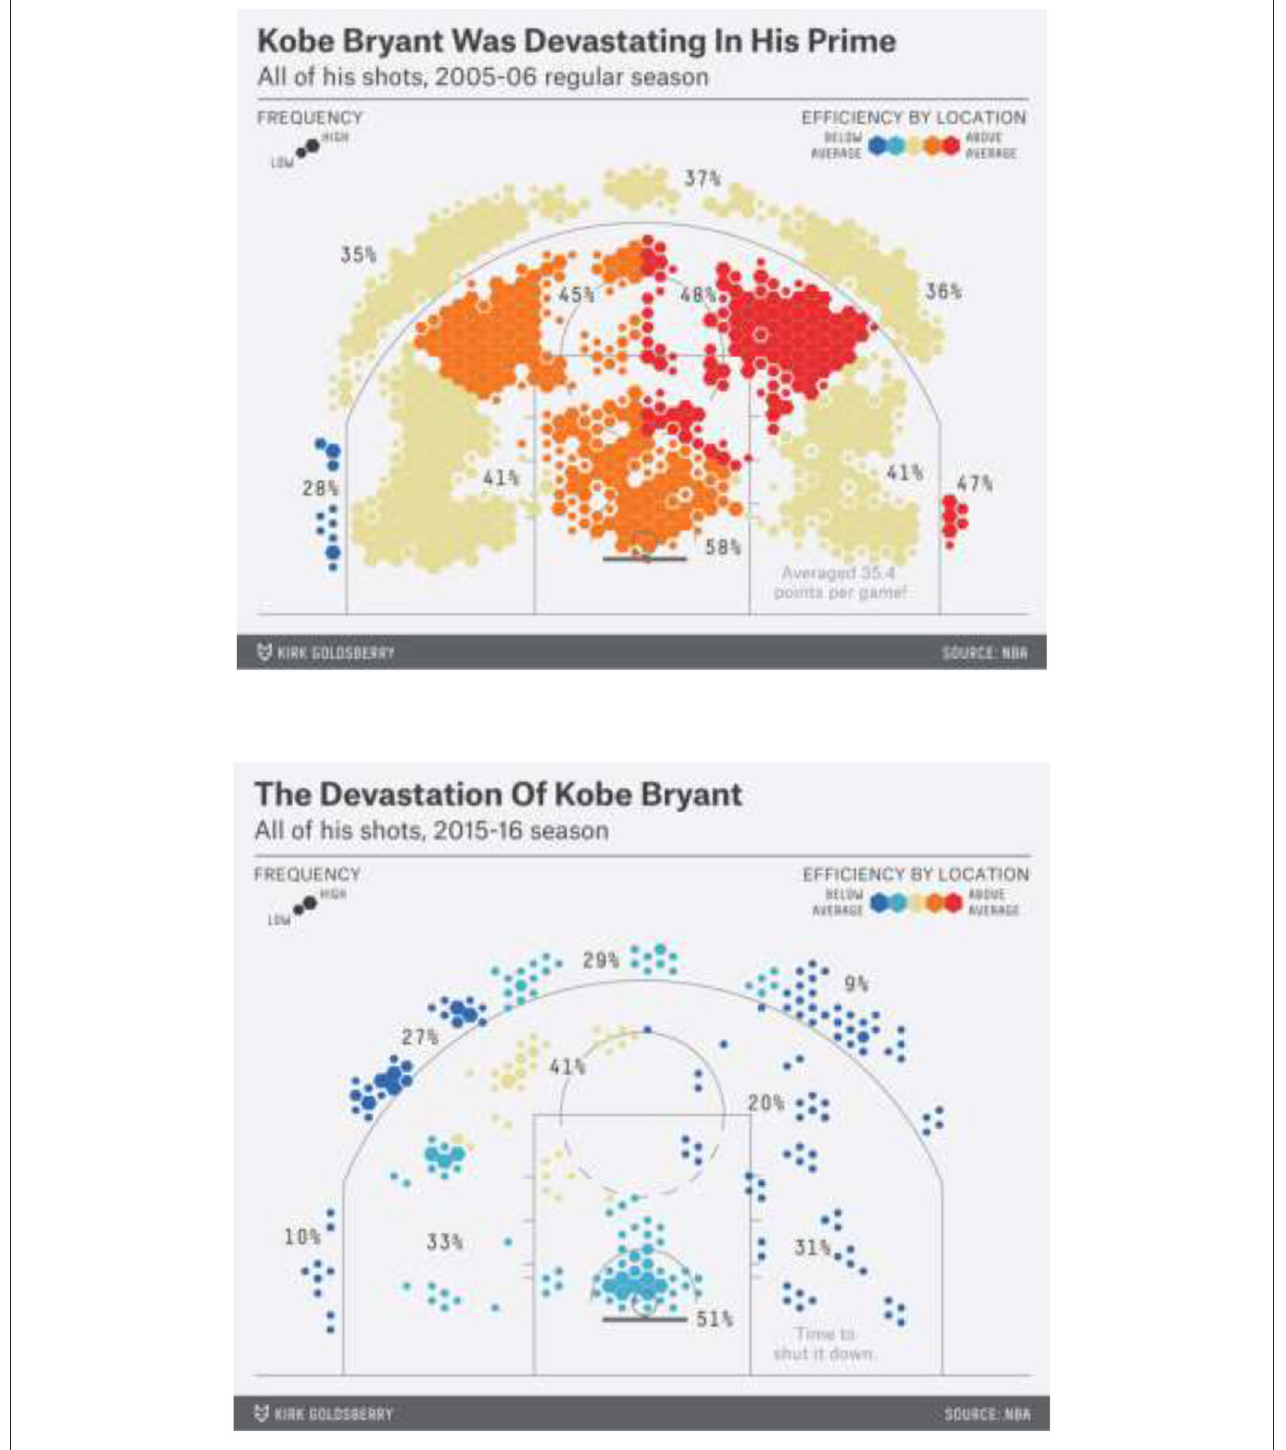
FIGURE 2 | Tracking athlete performance decline: shooting efficiency analysis of Kobe Bryant 2005–2006 vs. 2015–2016. Source: reprinted with permission of Goldsberry (2019).